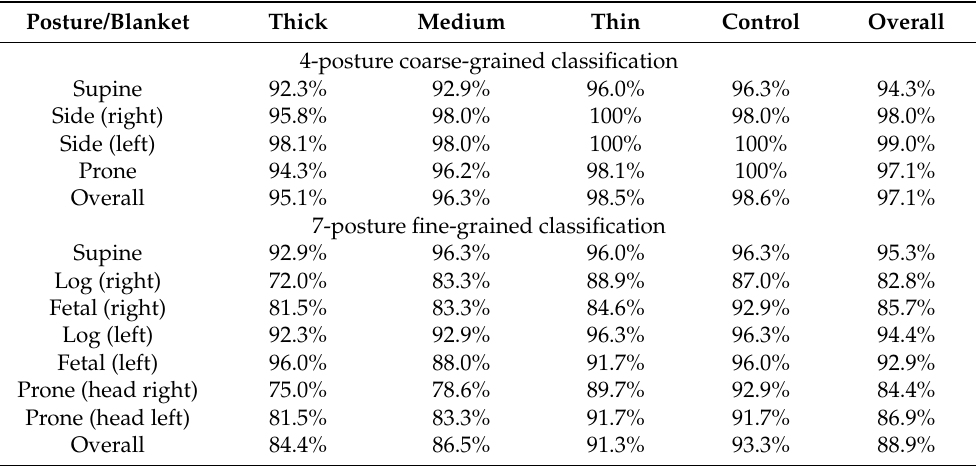
Table 2. Model performance (F1-score) of coarse- and fine-grained classifications in each posture and